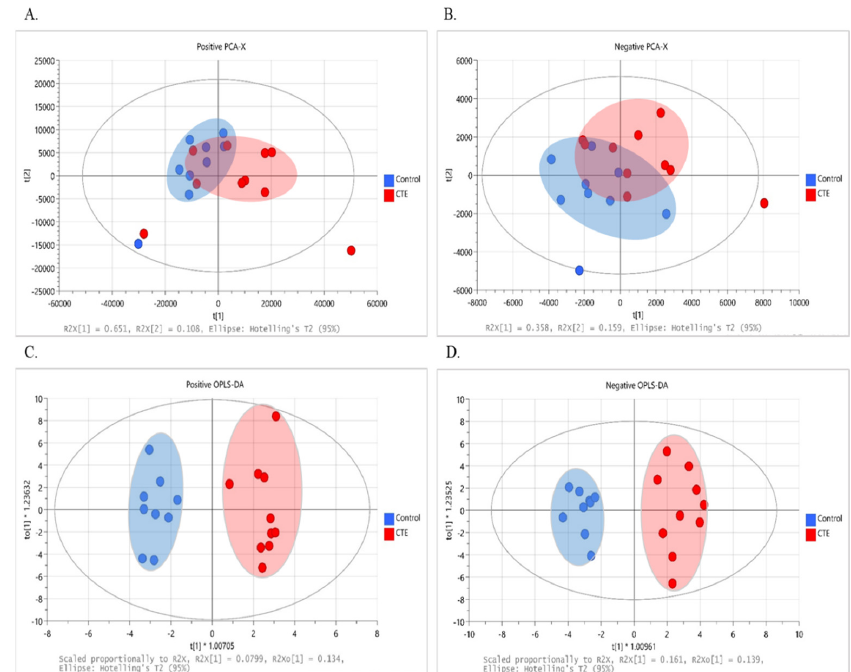
Figure 1. The results of multivariate analysis with 251 variables in the CTE (red) and healthy control groups (blue). ( A ) The PCA score plot at positive ionization mode. ( B ) The PCA score plot at negative ionization mode. ( C ) The OPLS–DA score plot at positive ionization mode. ( D ) The OPLS–DA score plot at negative ionization mode. PCA: principal component analysis; OPLS–DA: orthogonal projection to latent structure–discriminant analysis; CTE: chronic traumatic encephalopathy. Table 1. The summary of putatively identified significant